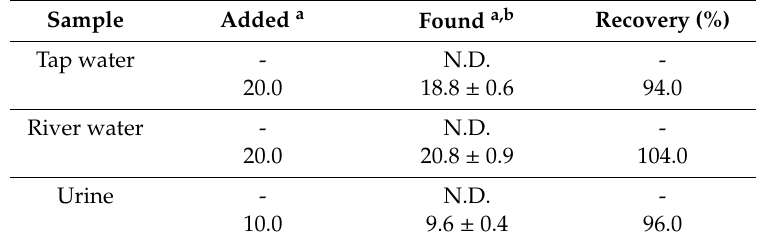
Table 5. Analytical results of thallium determination in spiked aqueous and urine samples. Sample Added